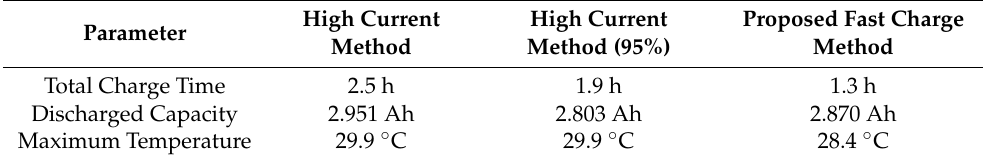
Table 4. Charge parameters of the high current method and the proposed fast charge